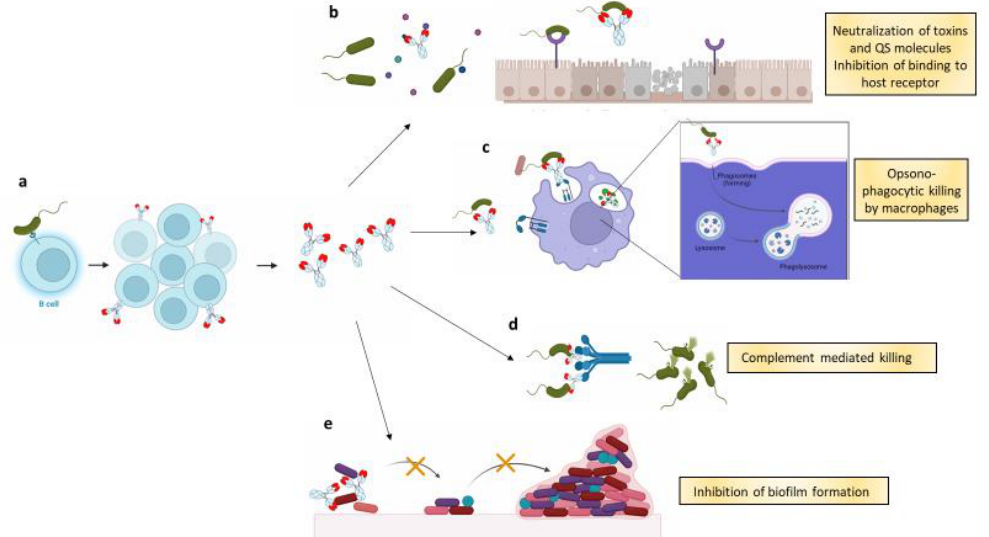
Figure 1. ( a ) B cells that are exposed to a single pathogen start replicating once they bind to a single virulence factor. The clones start expressing antibodies (monoclonal antibodies), which recognize the same virulence factor; ( b ) mAbs may act through Fab mediated functions, such as neutralization and inhibition of adhesion. In the first case, mAbs neutralize by binding to the toxins or to quorum sensing (QS) molecules released by the pathogenic bacteria, blocking the virulent effect exerted by the molecules. In the second case, mAbs bind to bacteria and inhibit their interaction with host cell’s receptors. In this way, bacteria cannot colonize the cell surface; ( c ) mAbs may enhance the opsono-phagocytic activity of macrophages. In some cases, they may also act intracellularly, promoting phago-lysosome formation and elimination of internalized bacteria; ( d ) once they bind to the pathogen, mAbs recruit complement components to initiate the complement cascade, resulting in bacterial lysis by the membrane attack complex (MAC); ( e ) lastly, mAbs that bind adhesins on bacterial surface disrupt the interactions within bacteria and between bacteria and the abiotic surface, thus interfering with biofilm